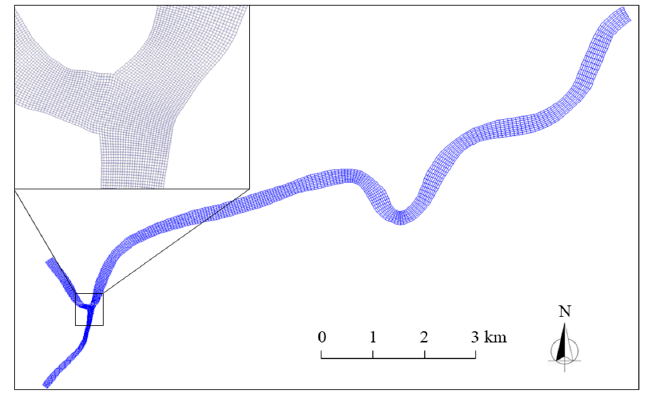
Figure 5. Computational domain with cells.